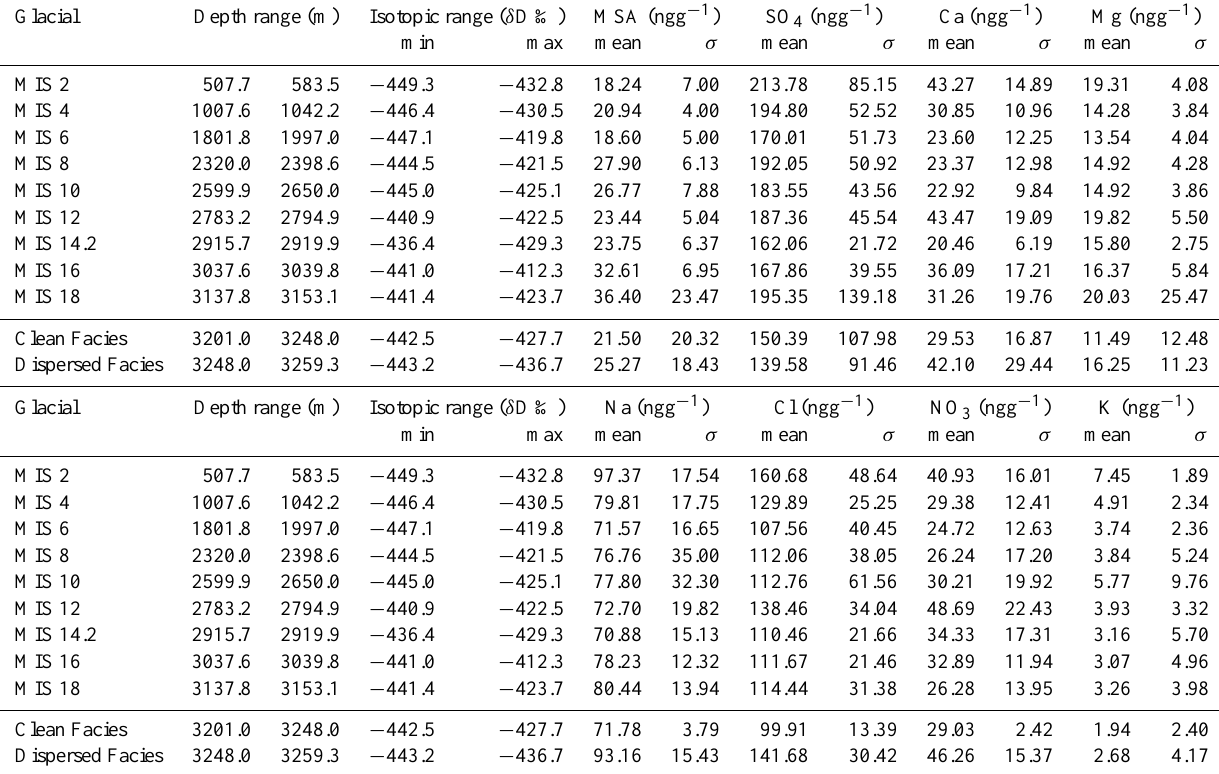
Table 1. Mean concentration and 1 σ values (ngg − 1 or ppb) for selected chemical species in the clean and dispersed basal ice facies of the EPICA Dome C ice core, as compared to those of the previous full glacial periods (see text for details). Depth (m) and δ D (‰) ranges are given for each time interval